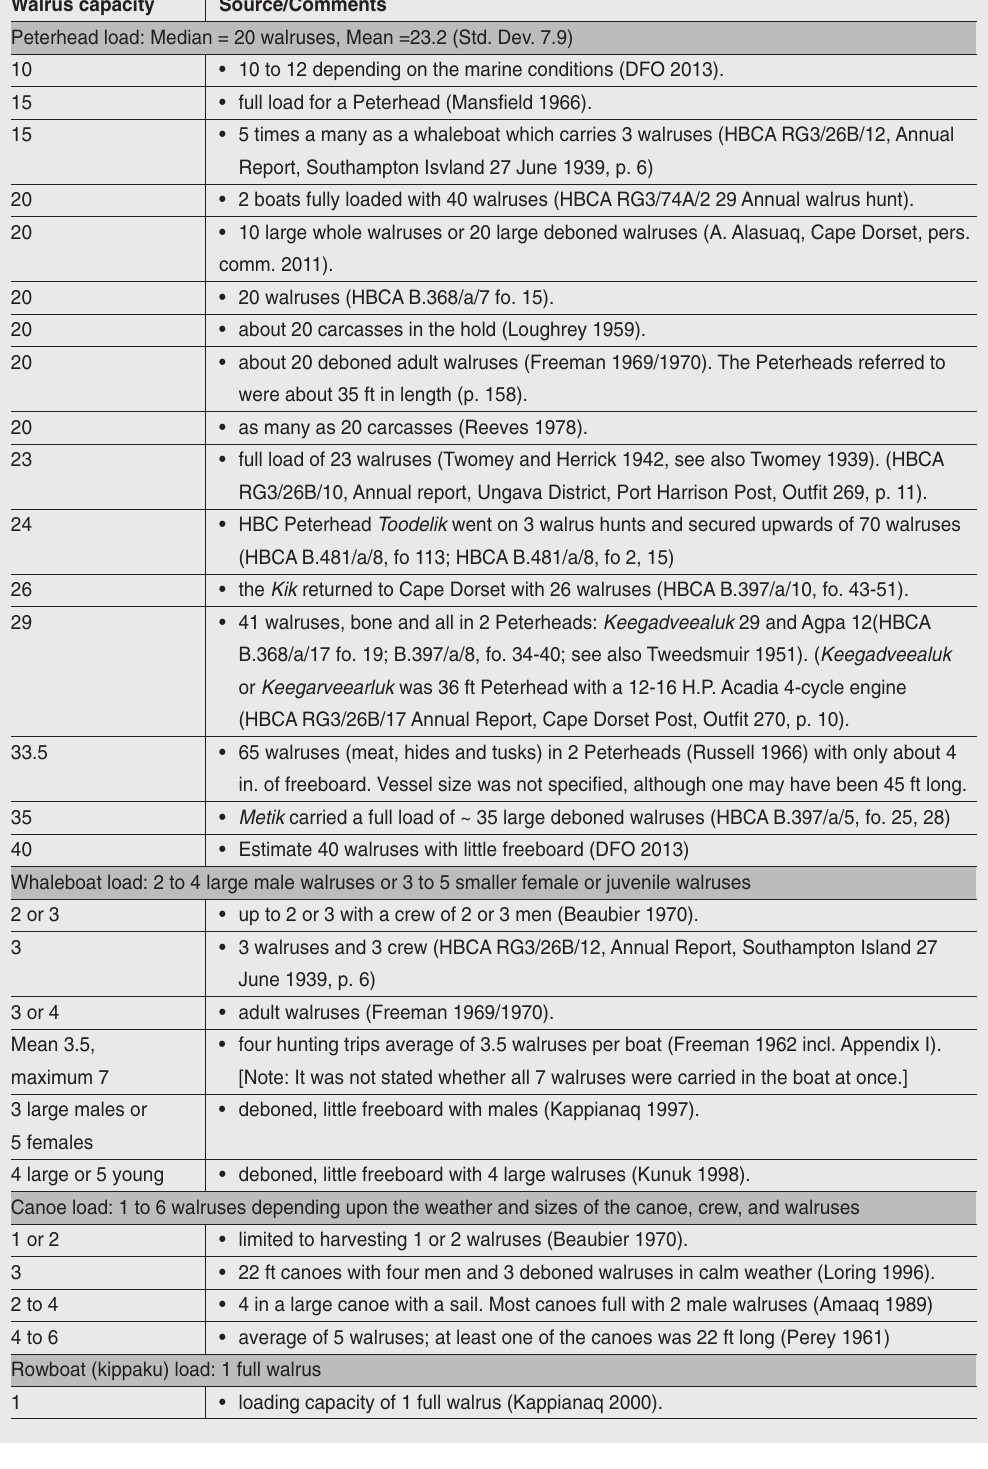
Table 1. Conversion factors for estimating walrus catches based on the descriptive term “boatloads”, cal- culated from hunts of the Canadian Central Arctic walrus population using a variety of boat types. Walrus